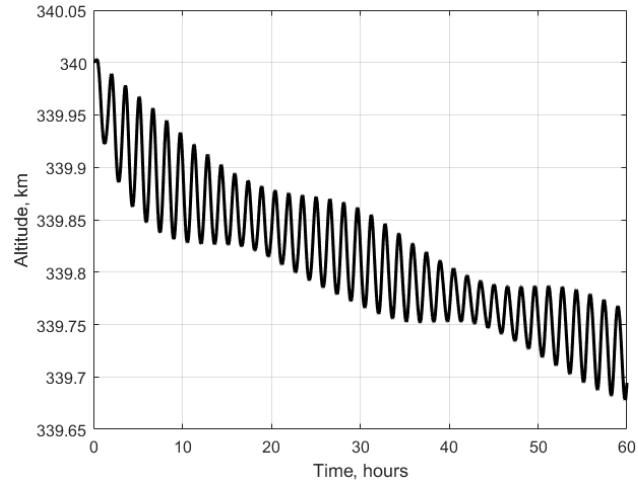
Figure 8. Orbit altitude during the simulation.